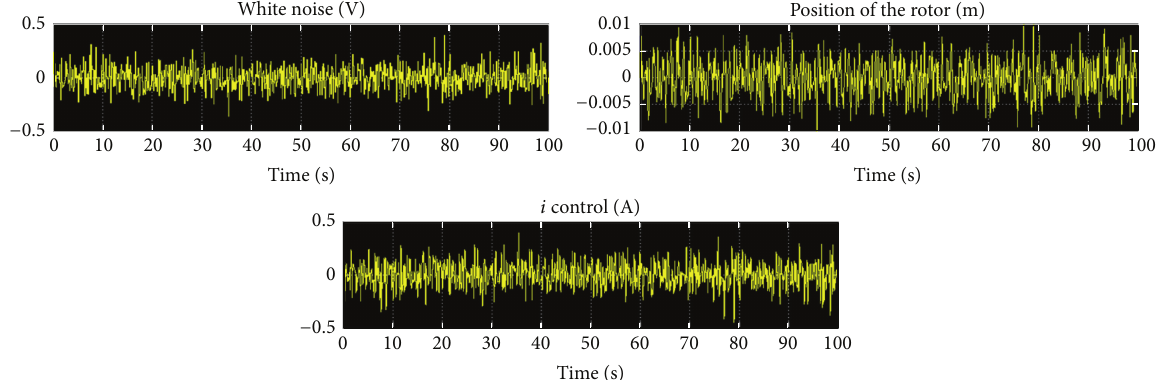
Figure 13: System response with PID controller with proportional gain of 22.1426, integral gain of 23.2457, and differential gain of 283.4574 and white noise of 0.001